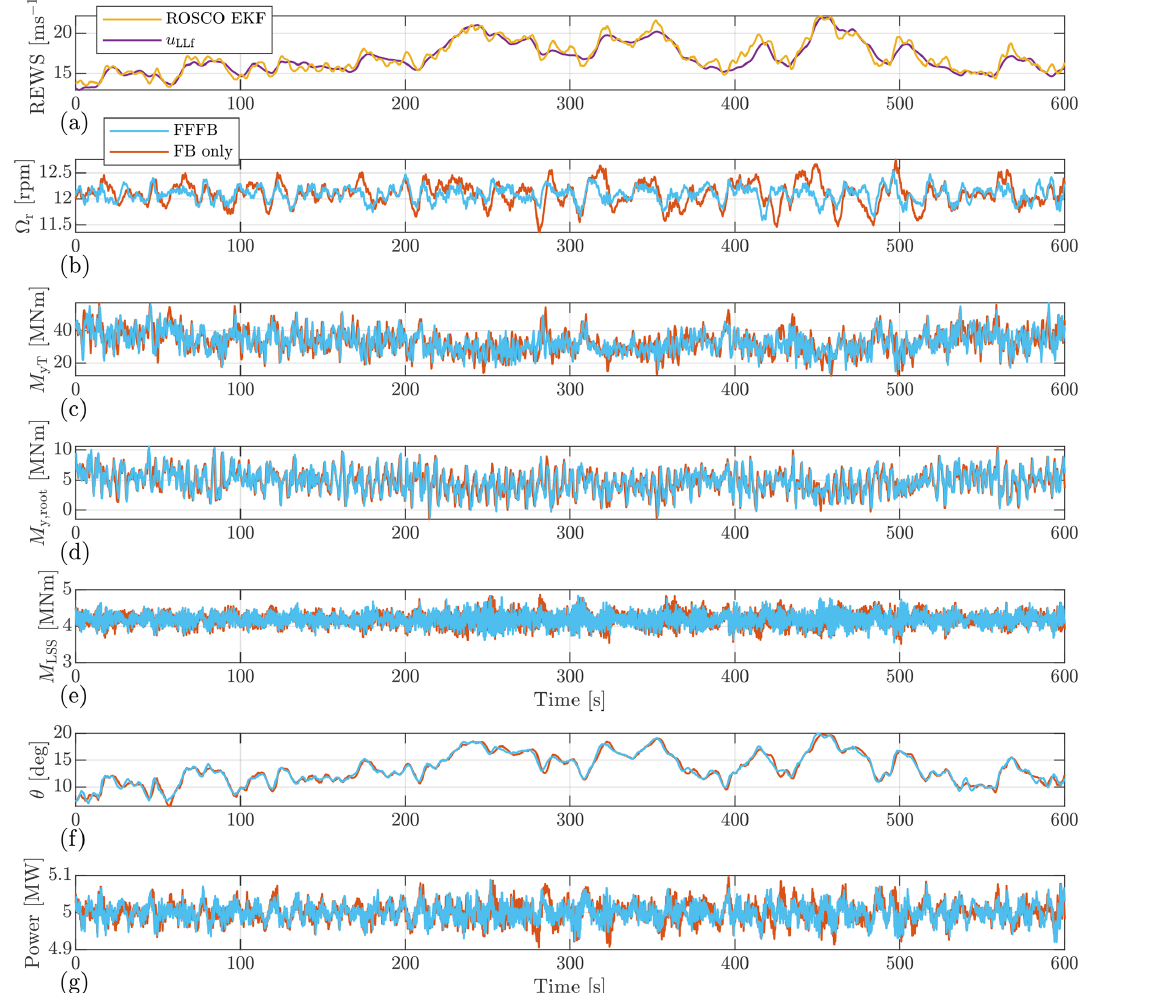
Figure 9. The time series collected from OpenFAST simulation. The case with the Mann model and neutral stability parameters is shown. Note the same 3D wind field ( y,z,t ) is applied to the rotor when performing simulations with the FFFB control and the FB-only control. Simulated with a mean wind speed of 16ms − 1 . EKF: extended Kalman